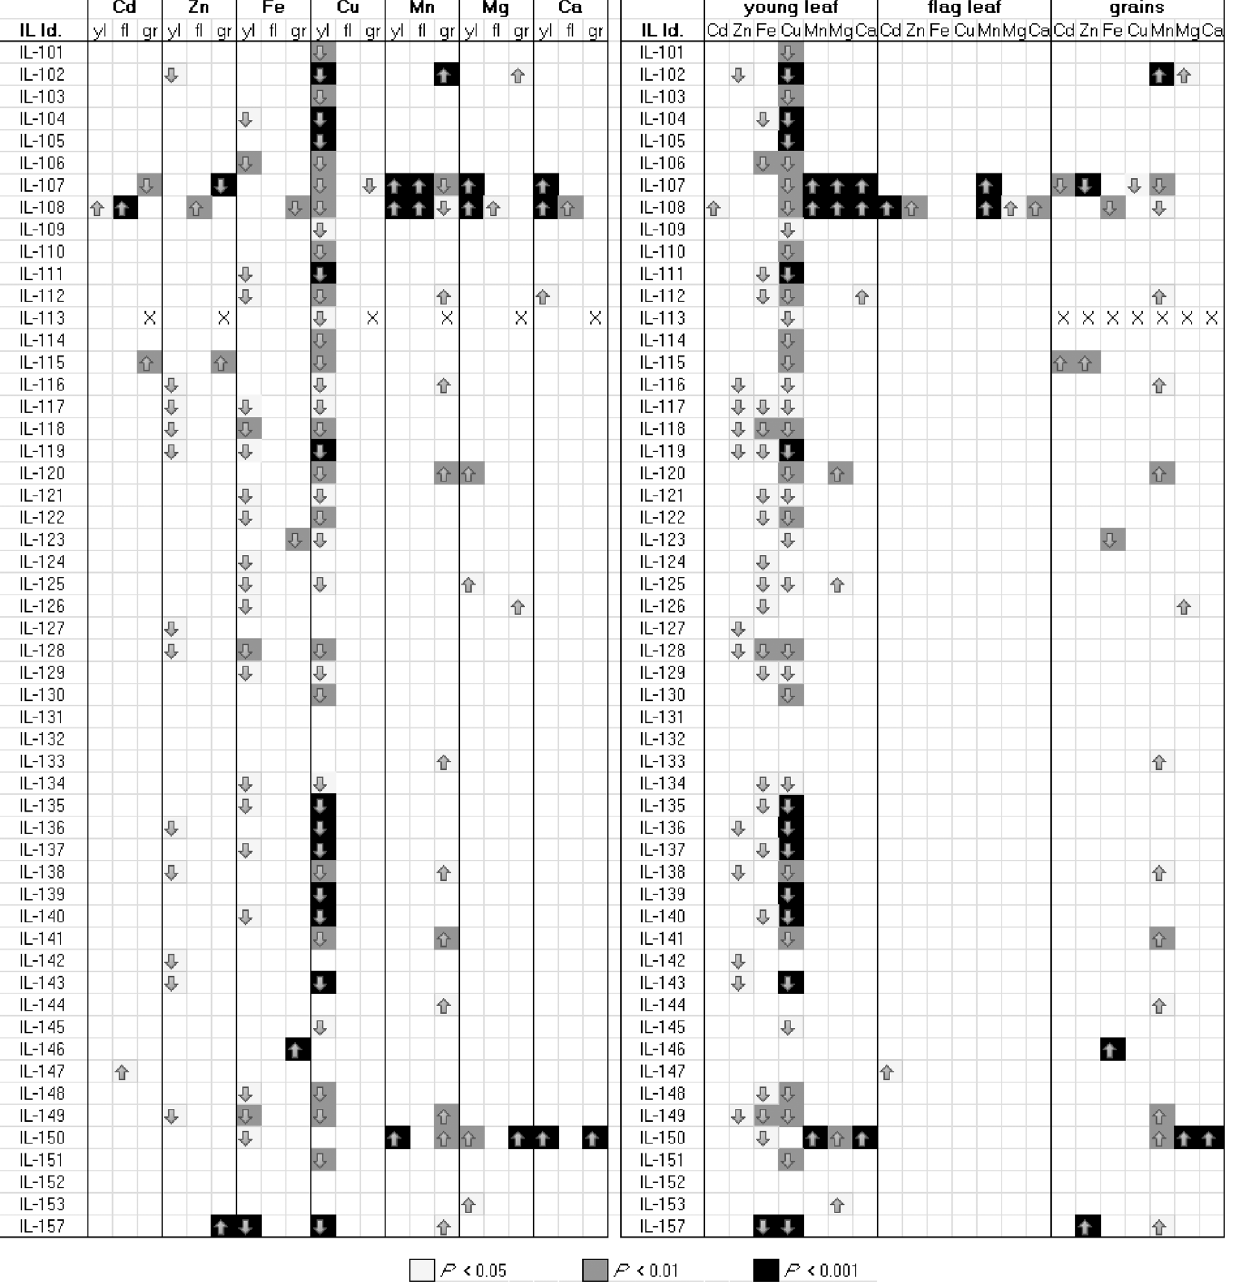
Fig 2. Overview of all QTL detected in all tissues. Shown is an overview of all statistically significant effects on concentrations of Cd, Zn, Fe, Cu, Mn, Mg and Ca in the young leaf (yl), flag leaf (fl) or the grains (gr). The same dataset is shown twice, (A) grouped by element, and (B) grouped by tissue. Arrows show the direction of the effect relative to the recurrent parent Scarlett, background color of boxes show P values as a measure of statistical significance (FDR_P; see legend). Genotype effects were detected using a mixed model approach as described in materials and methods (main text). Statistical significance was tested using Dunnett ’ s test, followed by FDR